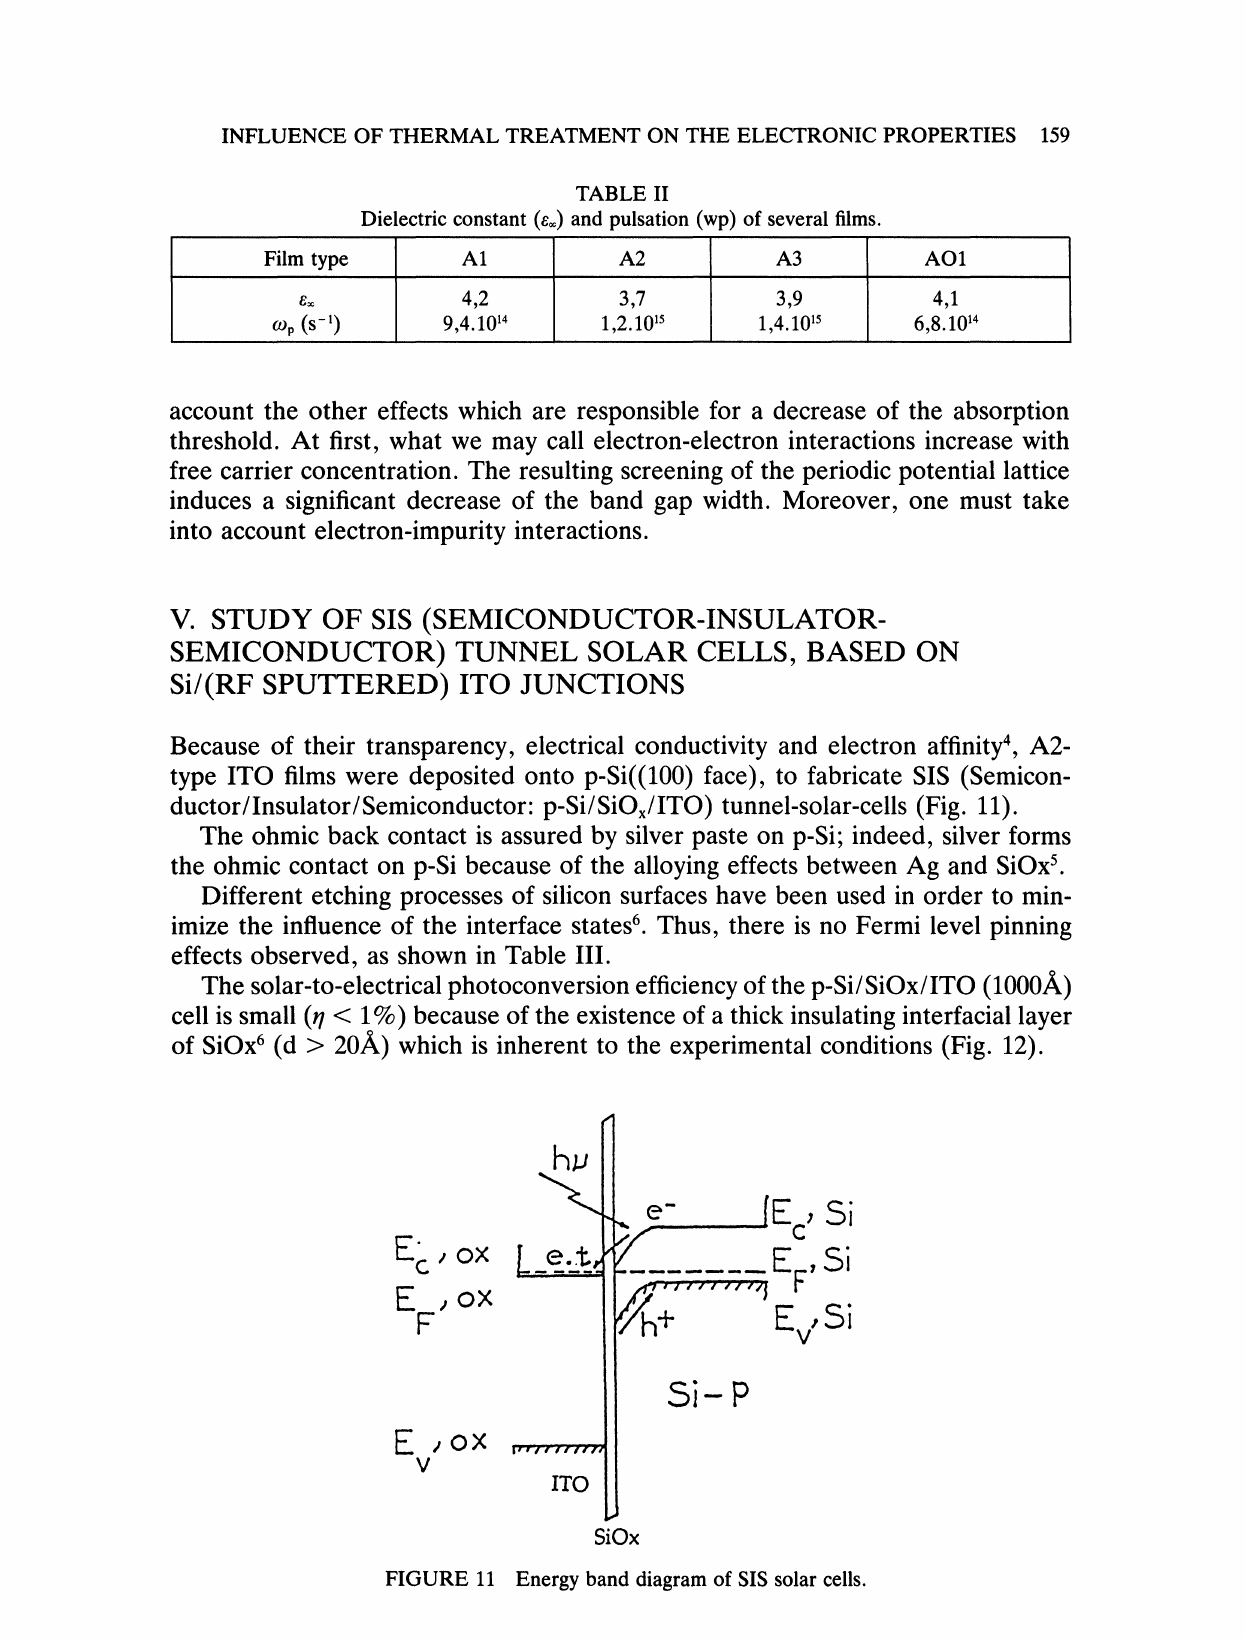
FIGURE 11 Energy band diagram of SIS solar